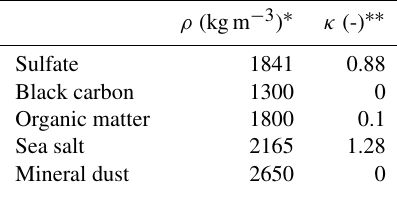
Table 1. Values of density ρ and the hygroscopic parameter κ for the five aerosol species considered in